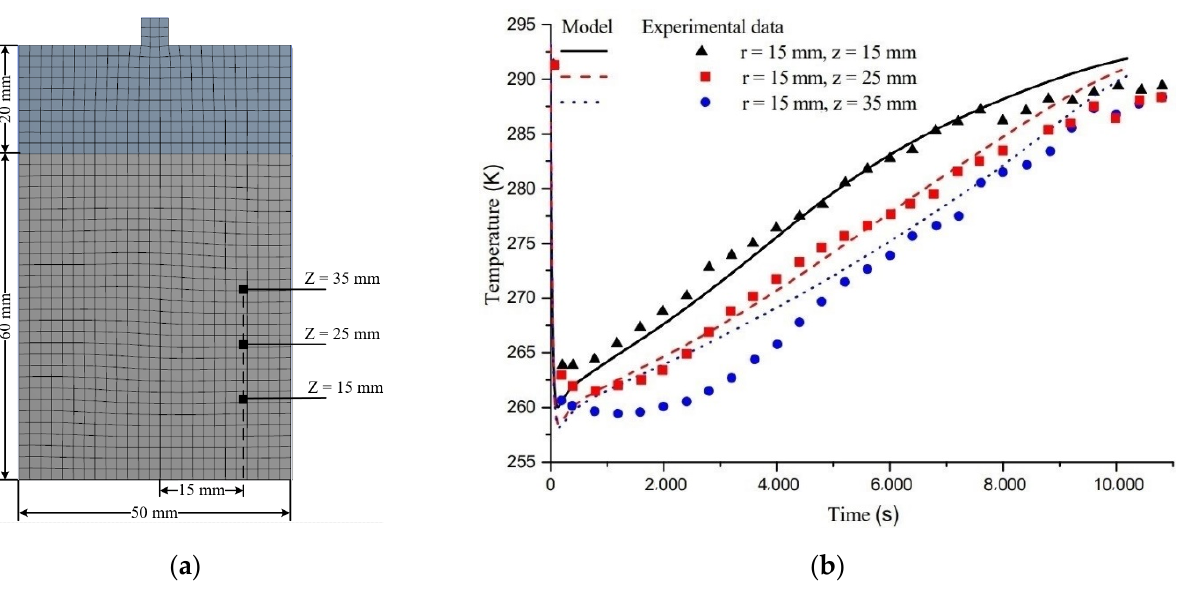
Figure 2. Comparisons of calculated and measured results. ( a ) Temperature measuring points; ( b ) simulation and experimental comparisons.